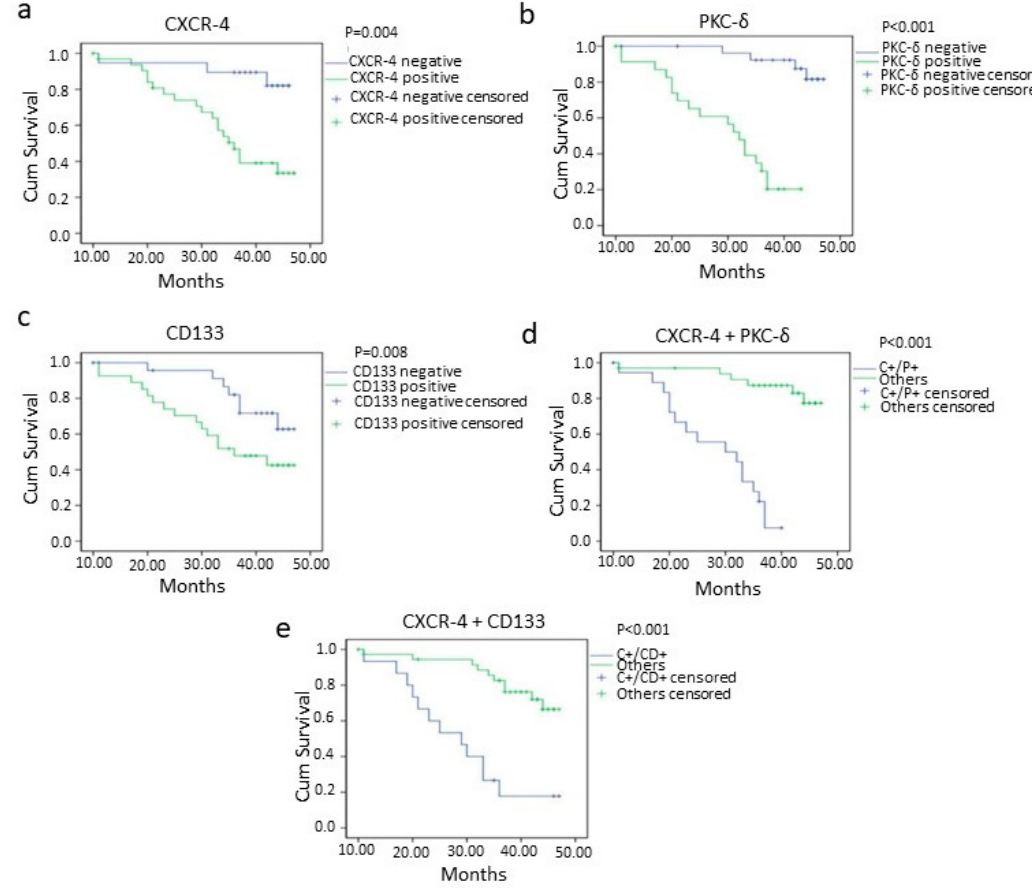
Figure 3. Double Immunofluorescence analysis of CXCR-4 with PKC- δ and CD133 in human esophageal cancer cell line H314. Upper panel: CXCR4 ( A ), PKC- δ ( B ), CXCR-4 and PKC- δ co-localization ( C ) and DAPI ( D ) staining in H314 cells. Lower panel: CXCR4 ( E ), CD133 ( F ), CXCR-4 and CD133 co-localization ( G ) and DAPI ( H ) staining in H314 cells (Scale bar—20 µm).